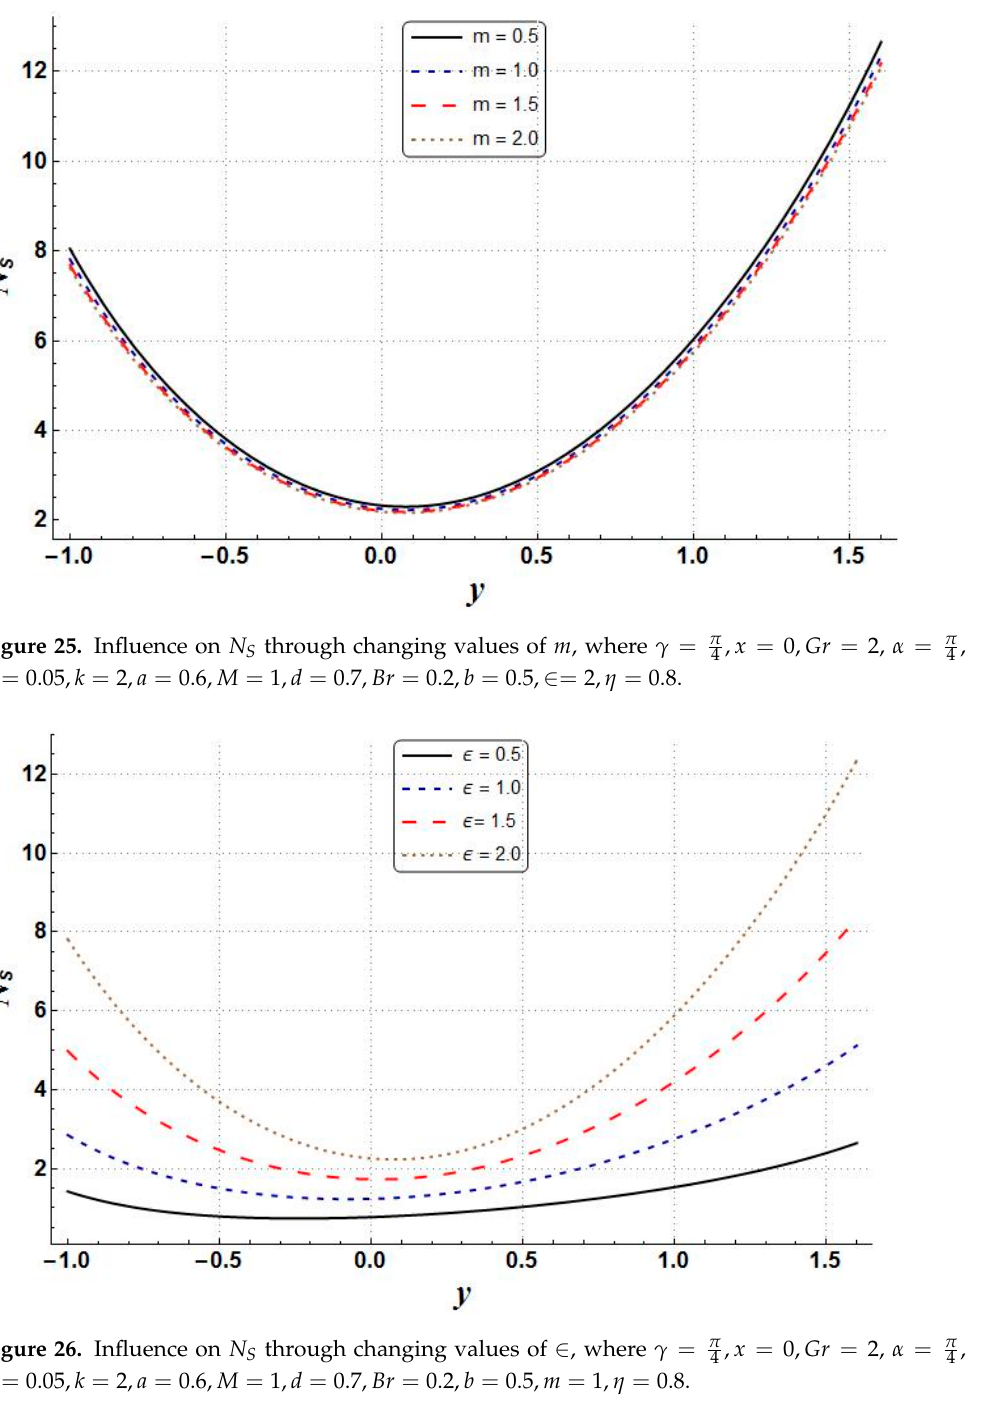
N through changing values of